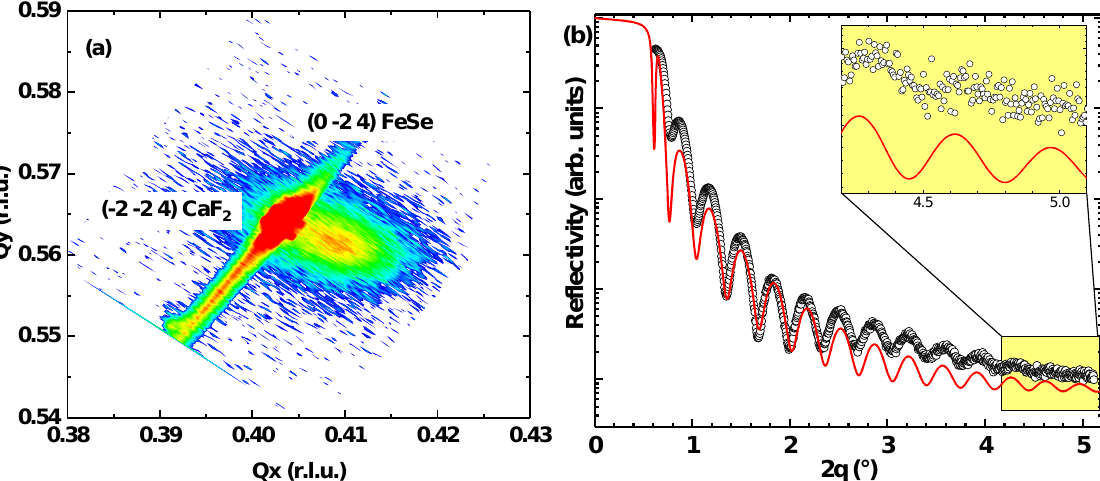
Figure 2. ( a ) Asymmetric reciprocal space maps of (0 − 2 4) FeSe film and ( − 2 − 2 4) CaF 2 substrate, ( b ) X-ray reflectivity curve of a FeSe film showing both experimental data (circles) and simulation (solid lines) deposited on CaF 2 (001)